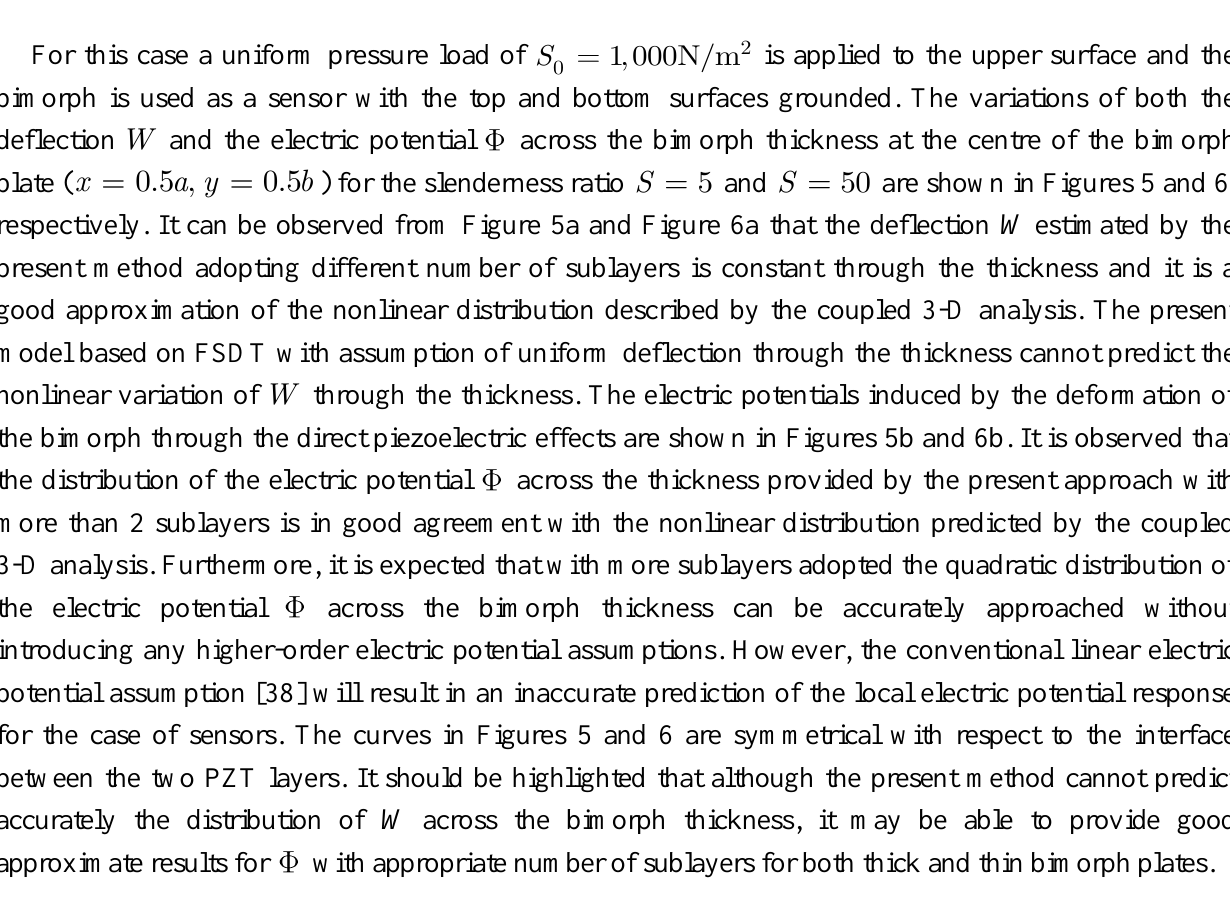
Figure 5. Bimorph sensor of 5 S under pressure load. ( a ) Dimensionless deflection; ( b ) Dimensionless electric potential. 3-D FE analysis (full line), present model with 2 n (triangles) and present model with 10 n (small